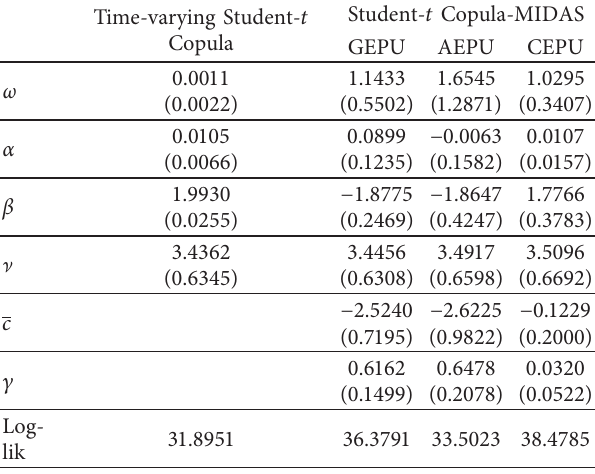
Table 6: Estimation results for dynamic Student- t Copulas.